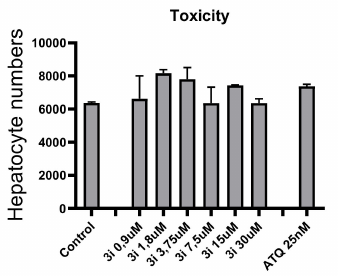
Figure 6. Toxicity of ( 3i ) on human